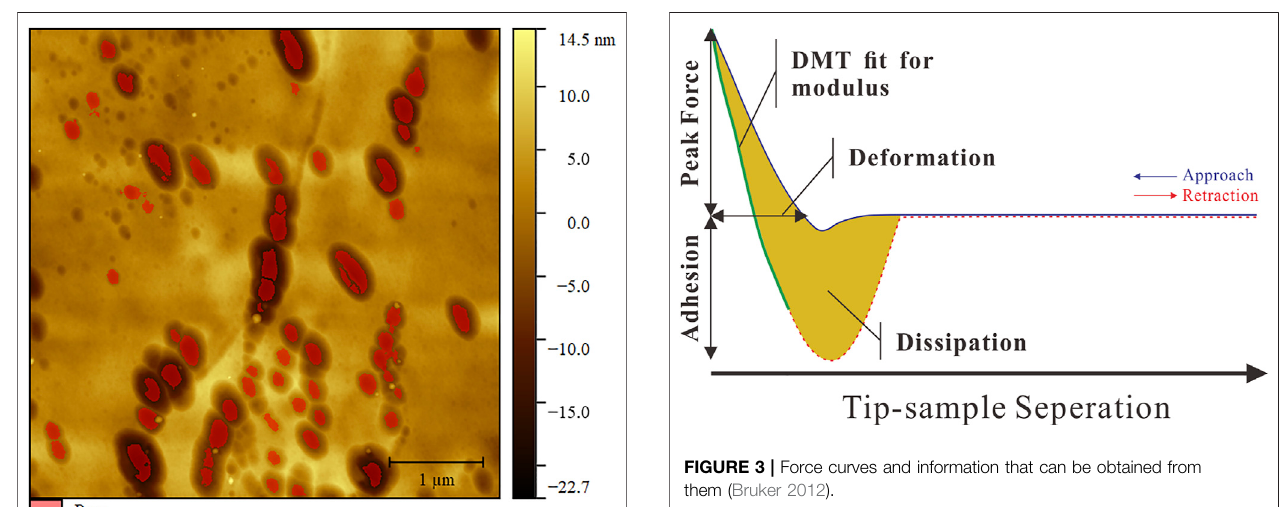
( Figure 2 ). Ten topography images were analyzed to produce average pore parameters for each sample.